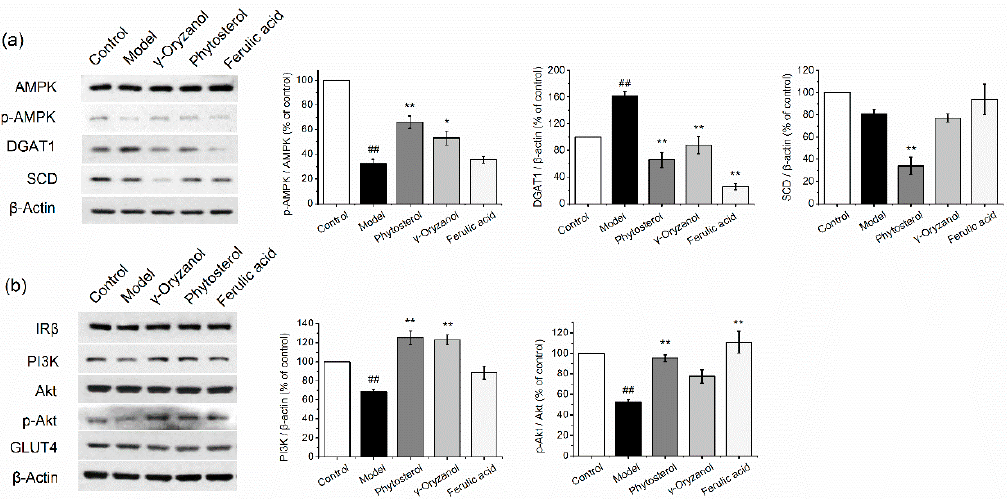
Figure 2. Western blot analysis of lipid ( a ) and glucose ( b ) metabolism-related protein expressions in HepG2 cells. Proteins were extracted from induction medium (10 mM glucose, 15 mM fructose and 1 mM FFA)-treated HepG2 cells with or without functional components (100 µ M). 1% BSA in incomplete DMEM was selected as the control. Data are presented as mean ± SEM ( n = 3). ## p < 0.01 vs. control. * p < 0.05 vs. model. ** p < 0.01 vs. model.